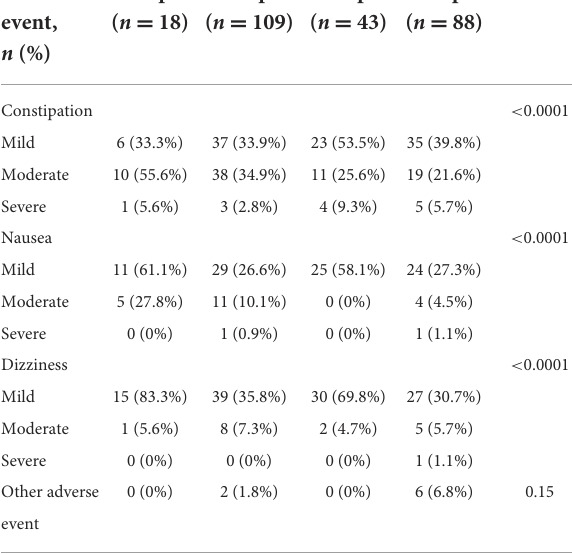
TABLE 5 Adverse events associated with the four treatment